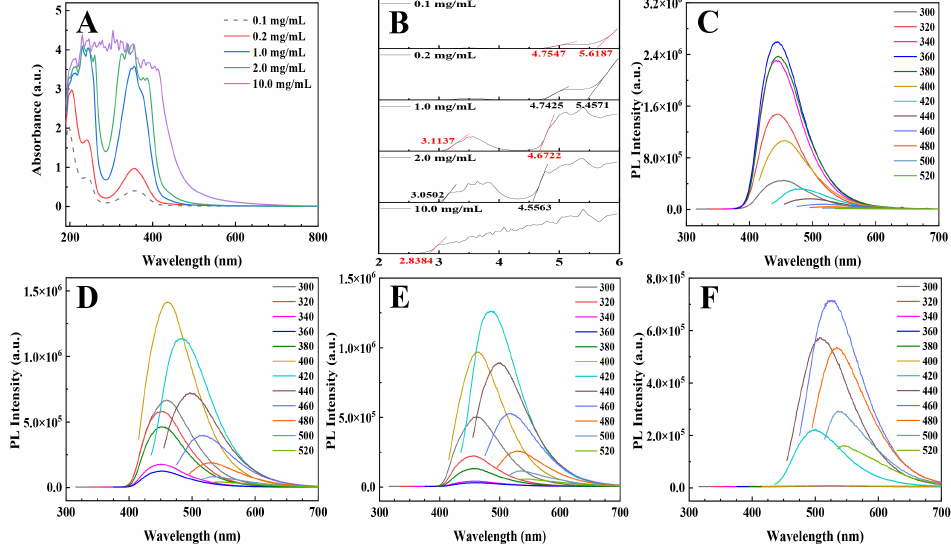
Figure 7. ( A ) UV–Vis absorption spectra and ( B ) the calculated energy band gaps of PEI@CNDs at various concentrations (0.1, 0.2, 1.0, 2.0, and 10.0 mg/mL); PL spectra of PEI@CNDs at higher concentrations of ( C ) 0.2 mg/mL, ( D ) 1.0 mg/mL, ( E ) 2.0 mg/mL, and ( F ) 10.0 mg/mL.